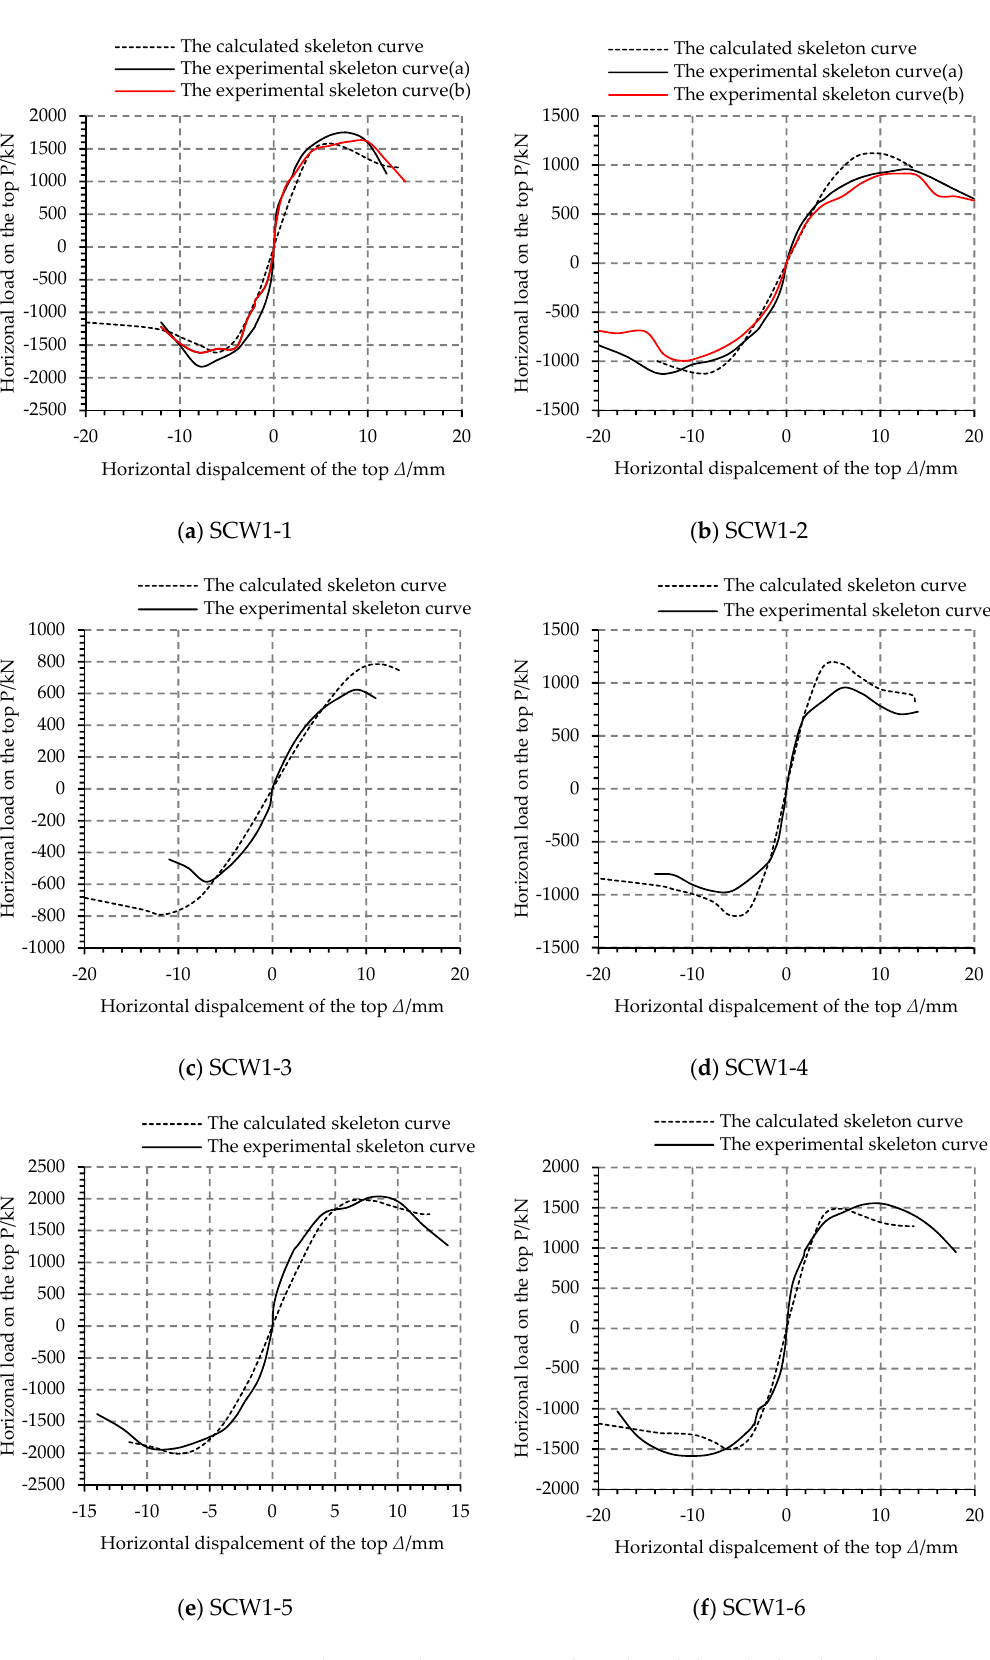
Figure 3. Comparisons between the experimental result and the calculated result.